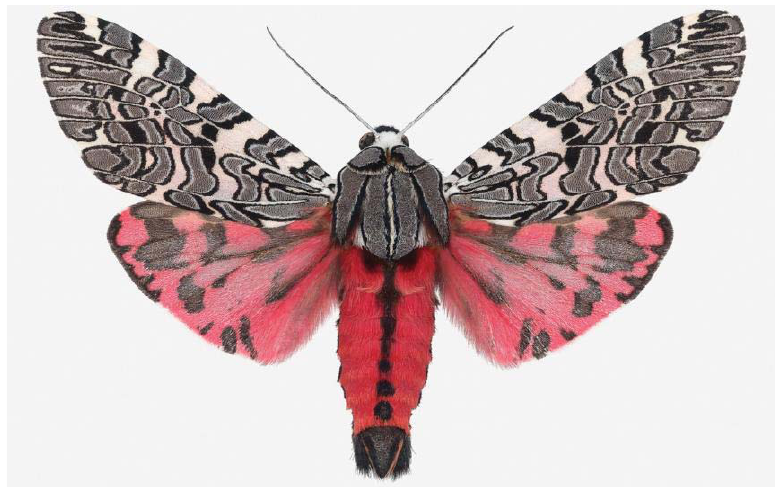
Figure 9. Another brightly colored Arizona tiger moth, Arachnis picta .